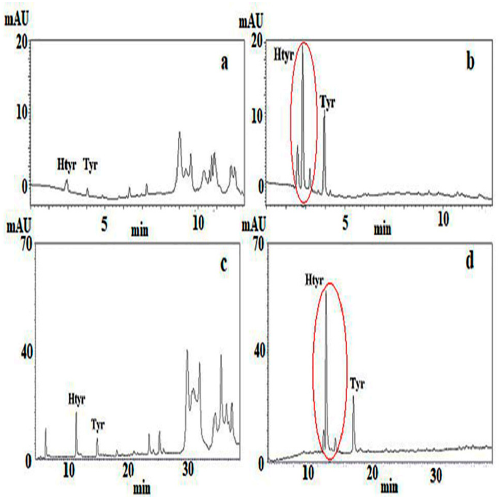
Figure 1. Profile at 280 nm of S-26 VOO polar fraction (PF) prior ( a , c ) and after ( b , d ) acidic hydrolysis using protocol A ( a , b ) and protocol B ( c , d ).